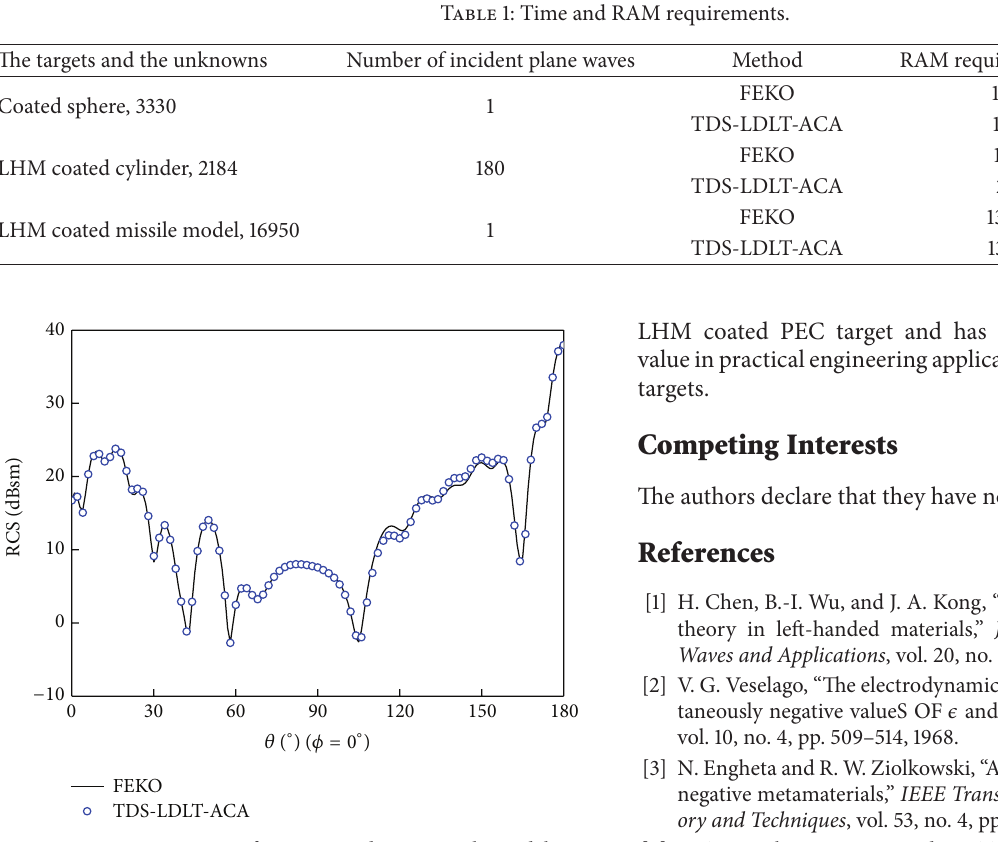
𝜃 = 90 ∘ and 𝜑 = 270 ∘ . Bistatic RCS is shown in Figure 6 along with the reference solution provided by FEKO. We observe that the agreement between the FEKO results and those obtained with the TDS-LDLT-ACA method is excellent. There exists difference between the incident angles 110 ∘ < 𝜃 < 160 ∘ ; however, the difference of scattering results is rela- tively